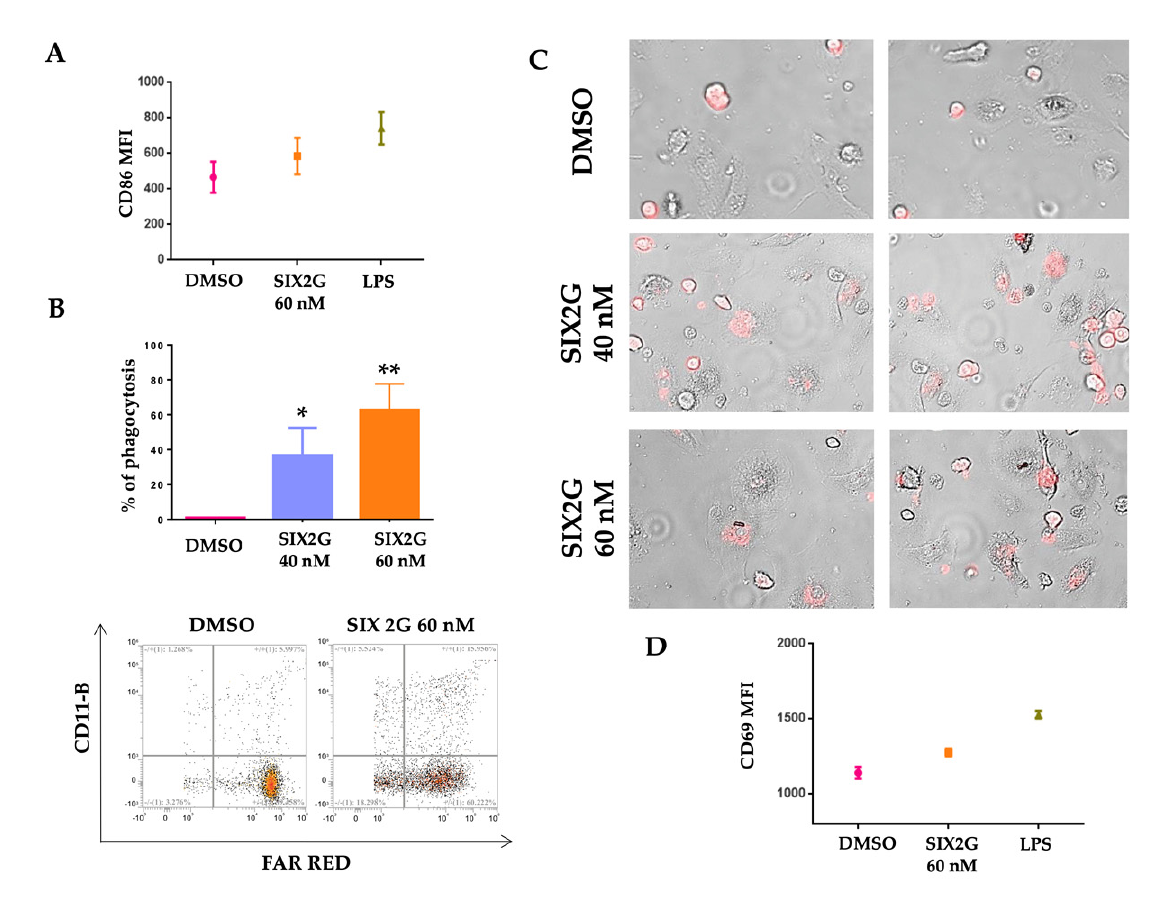
Figure 7. Assessment of DC maturation and phagocytosis. Representative figure of flow cytometric analyses conducted on DMSO or SIX2G pre-treated AMO-1 cells after 24 h of co-culture with DCs (E:T of 5:1). Scatter plots represent mean ± SD of MFI of CD86 signal, stimulation with lipopolysac- charide (LPS) was used as positive control of DC activation ( A ). Histogram bars represent the % of phagocytosis of cells treated with SIX2G with respect to DMSO (( B ) upper panel). This percentage was calculated as follows: mixed AMO-1 Far Red + cells and DCs were stained with CD11b, and with 7AAD to exclude apoptotic cells. Phagocytosed AMO-1 cells were detected as CD11b + , FAR RED + and 7AAD − cells. (Representative dot plots of flow cytometric analysis are represented in figure ( B ) lower panel). Representative figures of immunofluorescence assay show the engulfment by DCs of Far Red stained AMO-1 cells. DMSO treated AMO-1 cells appear round and in suspension respect than DCs that are instead attached to the bottom of the plate, AMO-1 cells treated with SIX2G at 40 nM and 60 nM appear as engulfed in DCs ( C ) Magnification 40X, scatter plots in figure ( D ) represent mean ± SD of MFI of CD69 CTLs activation marker. CD69 signal was detected on CTLs after 24 h of co-culture with AMO-1 cells pre-treated with SIX2G at 60 nM (DMSO and LPS were used as negative and positive controls, respectively). Student’s t -test was applied to calculate the statistical significance between multiple group comparisons, respect than DMSO treated cells. p -value < 0.05 is indicated with one star (*), p -value < 0.01 with two stars